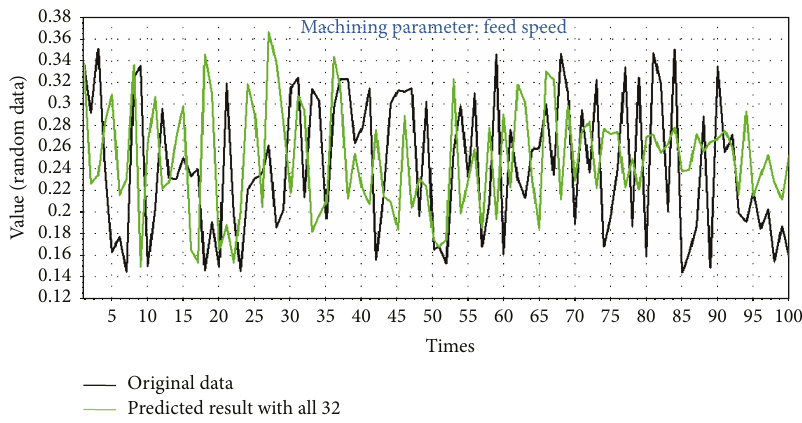
Machining parameter: feed speed